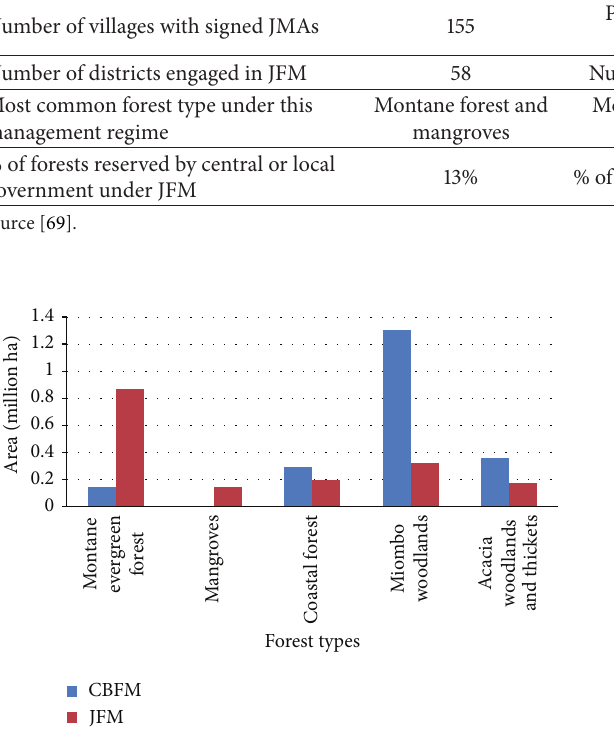
Figure 1: Forest management regime of Tanzania based on forest types and area covered. Source: MNRT